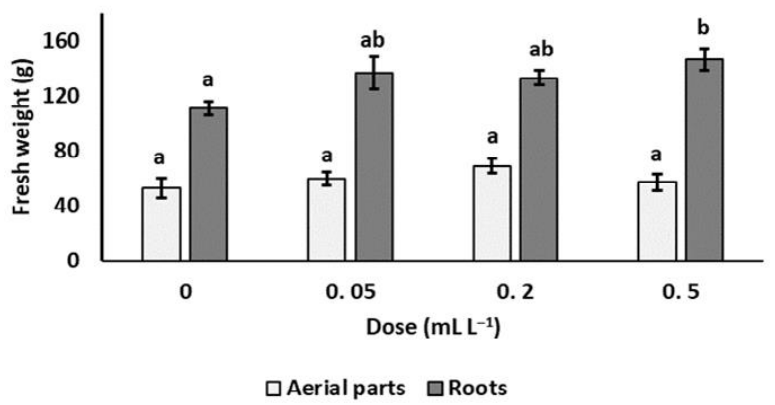
Figure 2. Effect of soil treatments with garlic extract formulation on the potted grapevine plants in soil infested with Xiphinema index . Values are means of seven replicates ± standard errors. For each plant part, bars marked by the same letters are not significantly different according to the Least Significant Difference Test ( p ≤ 0.05).